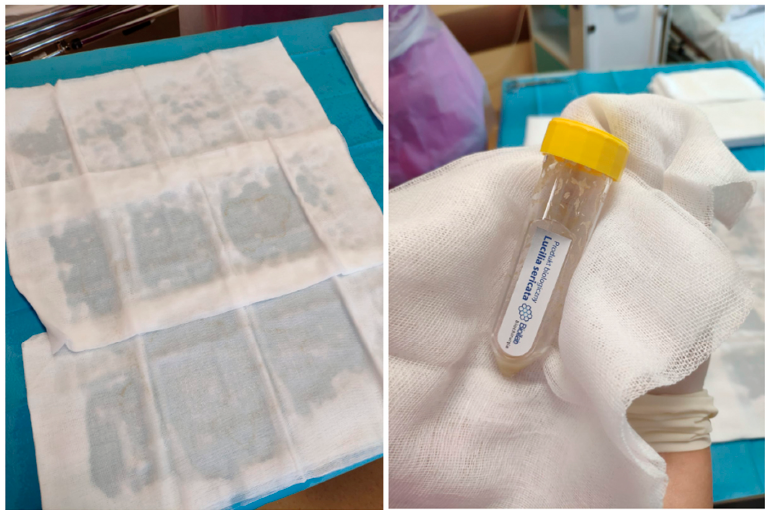
Figure 8. Picture before application of the larvae Lucilia sericata to the burn injury.